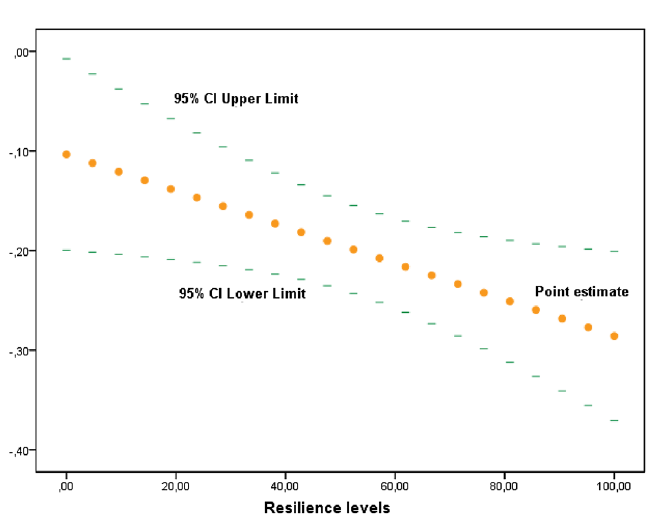
Figure 3. Johnson–Neyman method to study conditional effect of resilience as a moderator of the association between “Mood and Emotions” and Verbal victimization. Y-axis represents